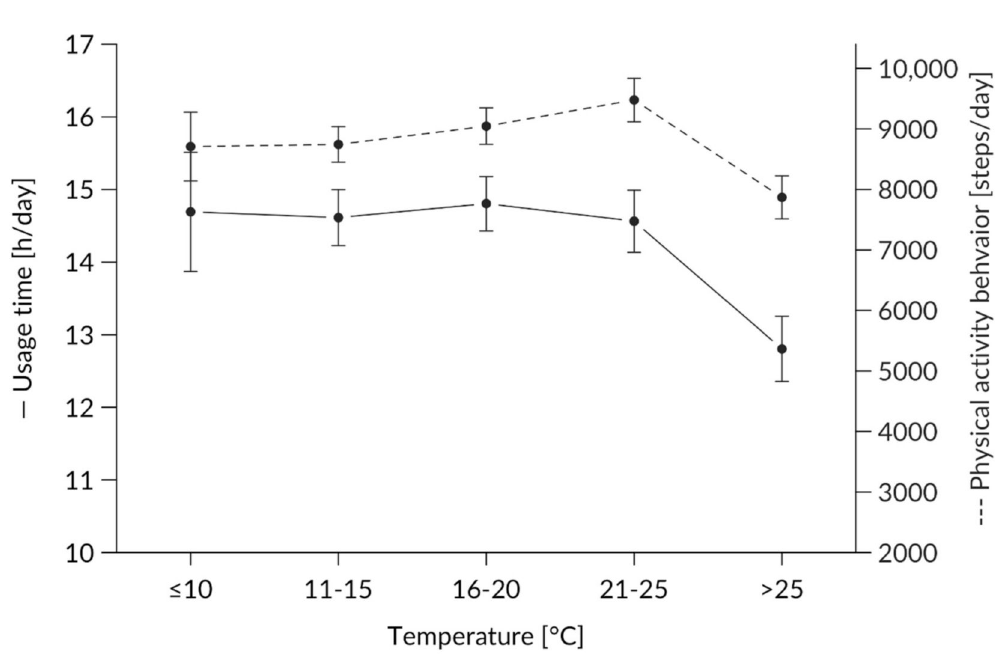
Figure 4. Average use per temperature depicted for usage time (h / day) on the y-axis on the left-hand side and physical activity behavior (steps / day) on the y-axis on the right-hand